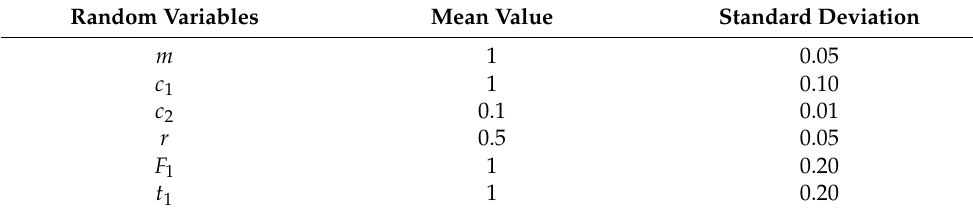
Figure 8. Convergence curves for different  in example 2. 4.3. Displacement Response of an Airfoil Example 3 is a practical engineering problem in which the proposed method is used in the reliability analysis for an airfoil. As shown in Figure 9, the airfoil is 1350 mm in length. The components of the airfoil include the main beam (made of carbon fiber), ribs (made of epoxy resin), front and rear walls (made of epoxy resin), and skin (made of glass fiber). The left end of the airfoil is fixed, and a uniform load is applied to its bottom. Then, its displacement response in the vertical direction is obtained by finite element analysis, as shown in Figure 10. Generally, when the displacement of the airfoil in the vertical di- rection is greater than one-tenth (135 mm in this case) of its length, the airfoil can be con- sidered as having failed [36]. The normal random variables in example 3 are independent of each other and their distribution is shown in Table 5. In order to examine the perfor- mance of this proposed method with different failure probabilities, the coefficient of var- iation for a uniform load is set as 0.05, 0.1, and 0.15.